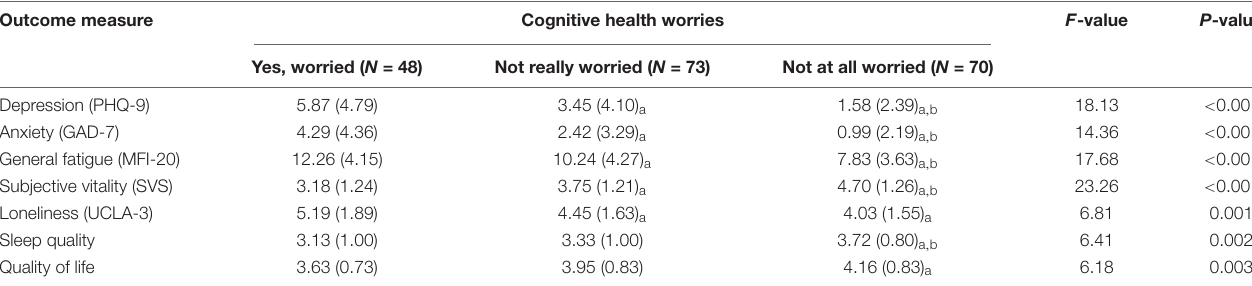
TABLE 2 | One way ANOVA